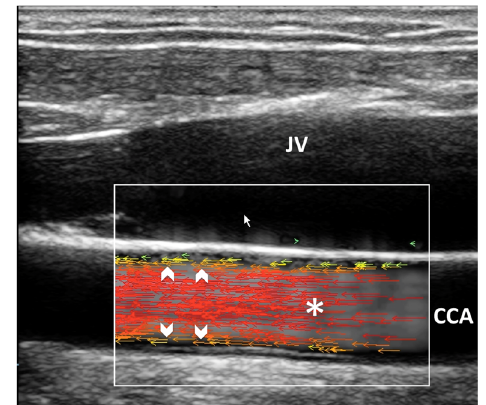
Fig. 3 VFI of a straight CCA. Blood flows in thin parallel layers ( red long vectors ; *). The fluid near the boundary ( orange/green vectors ) moves at low velocity ( arrowheads ). CCA = Common carotid artery. JV =